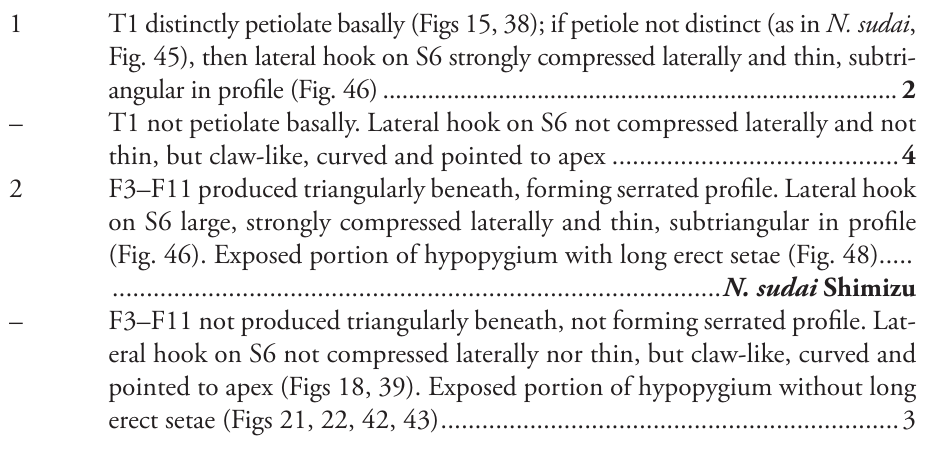
Transverse groove on S2 nearly straight (Shimizu et al. 2015: fig. 2E, arrow). T1 with long parallel-sided portion basally (Shimizu et al. 2015: fig. 8C) ..... ................................................................................... N. iwatai (Ishikawa) – Transverse groove on S2 subangulate (Shimizu et al. 2015: fig. 6F) or arcuate. T1 without parallel-sided portion basally (Shimizu et al. 2015: fig. 8D) ..... 6 6 Mandible short, its apex and two additional teeth rounded, basal tooth ves- tigial (Shimizu et al. 2015: fig. 8A) .................. N. mandibularis (Ishikawa) – Mandible normal-sized, its apex and two additional teeth pointed, basal tooth distinct (Shimizu et al. 2015: fig. 8B) ................................................ 7 7 Vertex strongly convex between eye tops; hence head in frontal view nearly circular in outline (Shimizu et al. 2015: fig. 1A). Posterior margin of ver- tex remarkably concave in dorsal view (Shimizu et al. 2015: fig. 1B). Gena strongly developed. F1 length 2.7–2.9× its width. Propodeum gently con- vex in profile (Shimizu et al. 2015: fig. 1C). S6 not carinate along midline. Fore wing inner fascia along crossvein cu-a broad and distinct (Shimizu et al. 2015: fig. 9A) ................................................. N. hayachinensis (Ishikawa) – Vertex not very strongly convex between eye tops; hence head in frontal view not circular in outline (Shimizu et al. 2015: figs 5A, 6A). Posterior margin of vertex not remarkably concave in dorsal view (Shimizu et al. 2015: figs 5B, 6C). Gena not strongly developed. F1 length 2.1–2.4× its width. Propodeum strongly convex in profile (Shimizu et al. 2015: figs 5C, 6D). S6 carinate along midline. Fore wing inner fascia along crossvein cu-a indistinct (Shimizu et al. 2015: figs 9F, 9H) .............................................................................. 8 8 Ocelli forming right- or obtuse-angled triangle and gena strongly receding posteriorly (Shimizu et al. 2015: fig. 5B).................... N. nagasei (Ishikawa) – Ocelli usually forming acute-angled triangle and gena roundly receding pos- teriorly (Shimizu et al. 2015: fig. 6C) .............................. N. rossicus (Lelej) Males (unknown for N. kurilensis , N. mandibularis, and N. hayachinensis ) 1 T1 distinctly petiolate basally (Figs 15, 38); if petiole not distinct (as in N. sudai , Fig. 45), then lateral hook on S6 strongly compressed laterally and thin, subtri- angular in profile (Fig. 46) ................................................................................ 2 T1 not petiolate basally. Lateral hook on S6 not compressed laterally and not thin, but claw-like, curved and pointed to apex .......................................... 4 2 F3–F11 produced triangularly beneath, forming serrated profile. Lateral hook on S6 large, strongly compressed laterally and thin, subtriangular in profile (Fig. 46). Exposed portion of hypopygium with long erect setae (Fig. 48)..... ......................................................................................... N. sudai Shimizu – F3–F11 not produced triangularly beneath, not forming serrated profile. Lat- eral hook on S6 not compressed laterally nor thin, but claw-like, curved and pointed to apex (Figs 18, 39). Exposed portion of hypopygium without long erect setae (Figs 21, 22, 42, 43)